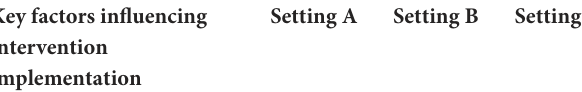
TABLE 2 Key factors influencing intervention implementation identified through qualitative content